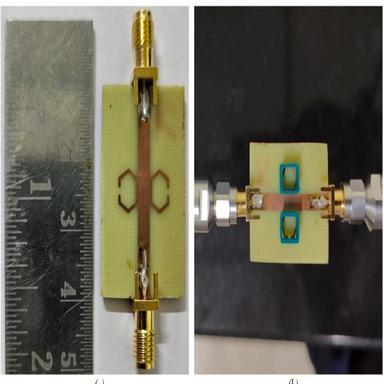
(a) Fabricated sensor prototype, (b) Sensor fitted with sample holder for measurement, (c) Unloaded sensor performance, and (d) Differential sensing in the presence of a sample.